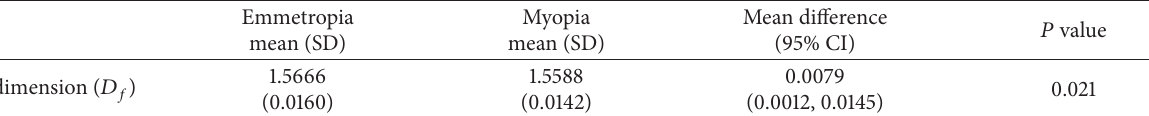
Table 3: Comparison of 𝐷 𝑓 between emmetropic and myopic groups.